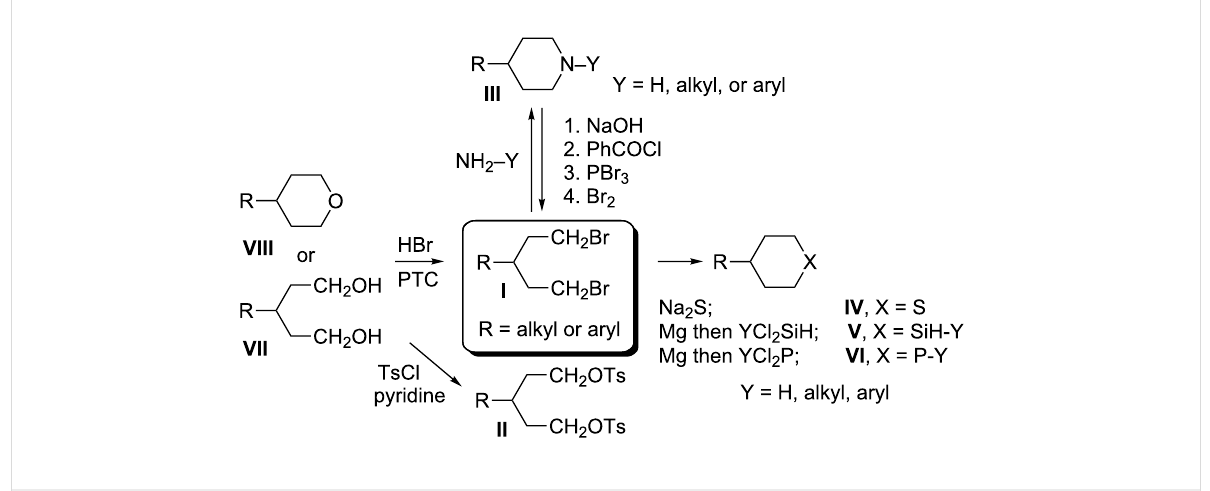
Figure 1: Methods for synthesis of dibromides I and their use for preparation of 6-membered heterocycles.